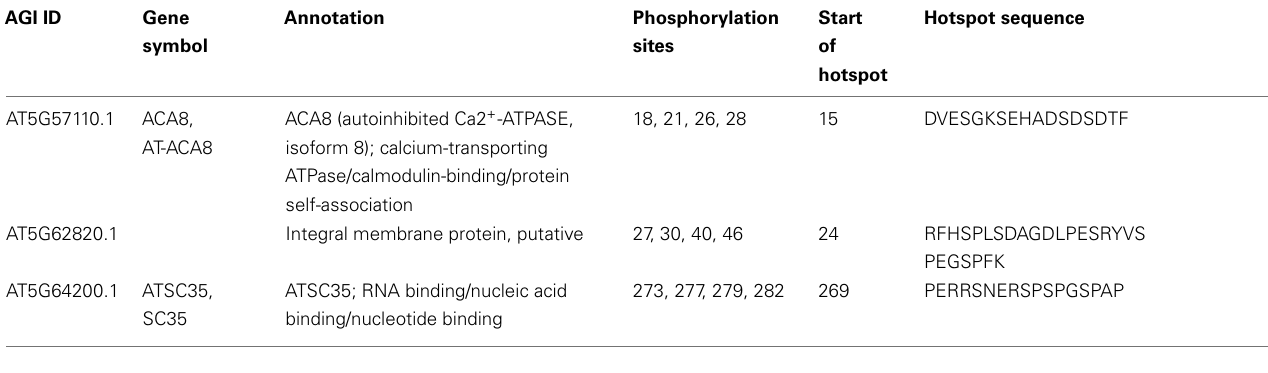
Table 2 | HotSPotter prediction performance.